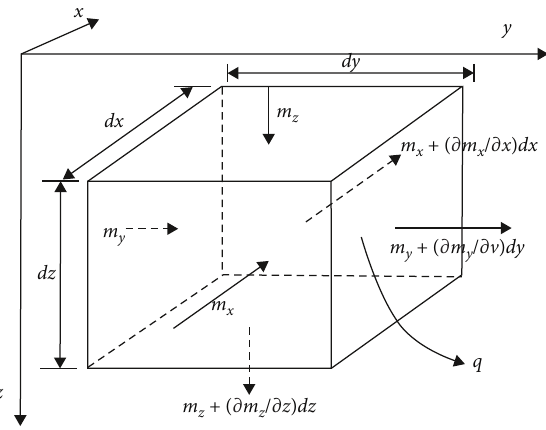
Figure 7: Mass conservation of